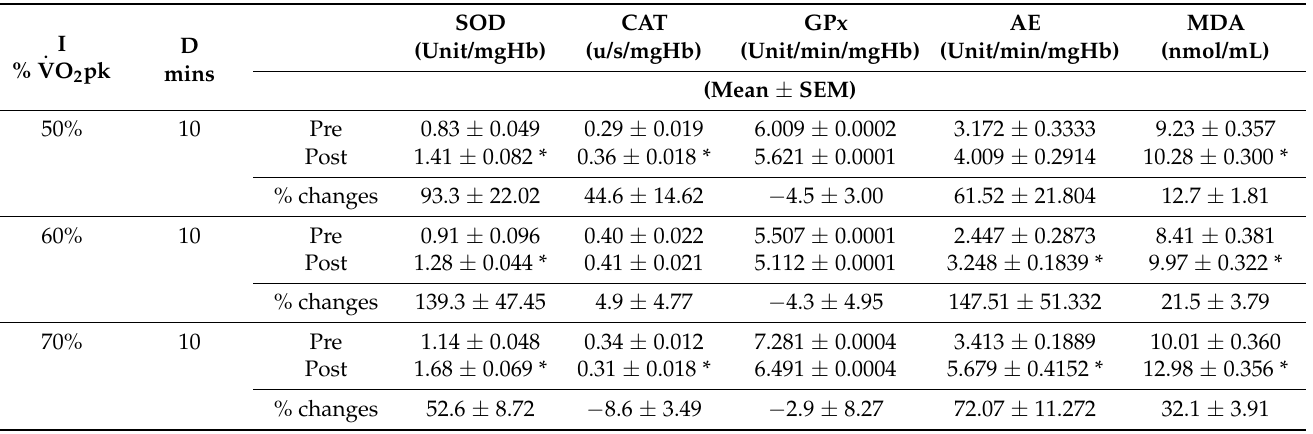
Table 3. Changes in antioxidant enzymes activities and MDA concentration after exercise intervention at different intensities and